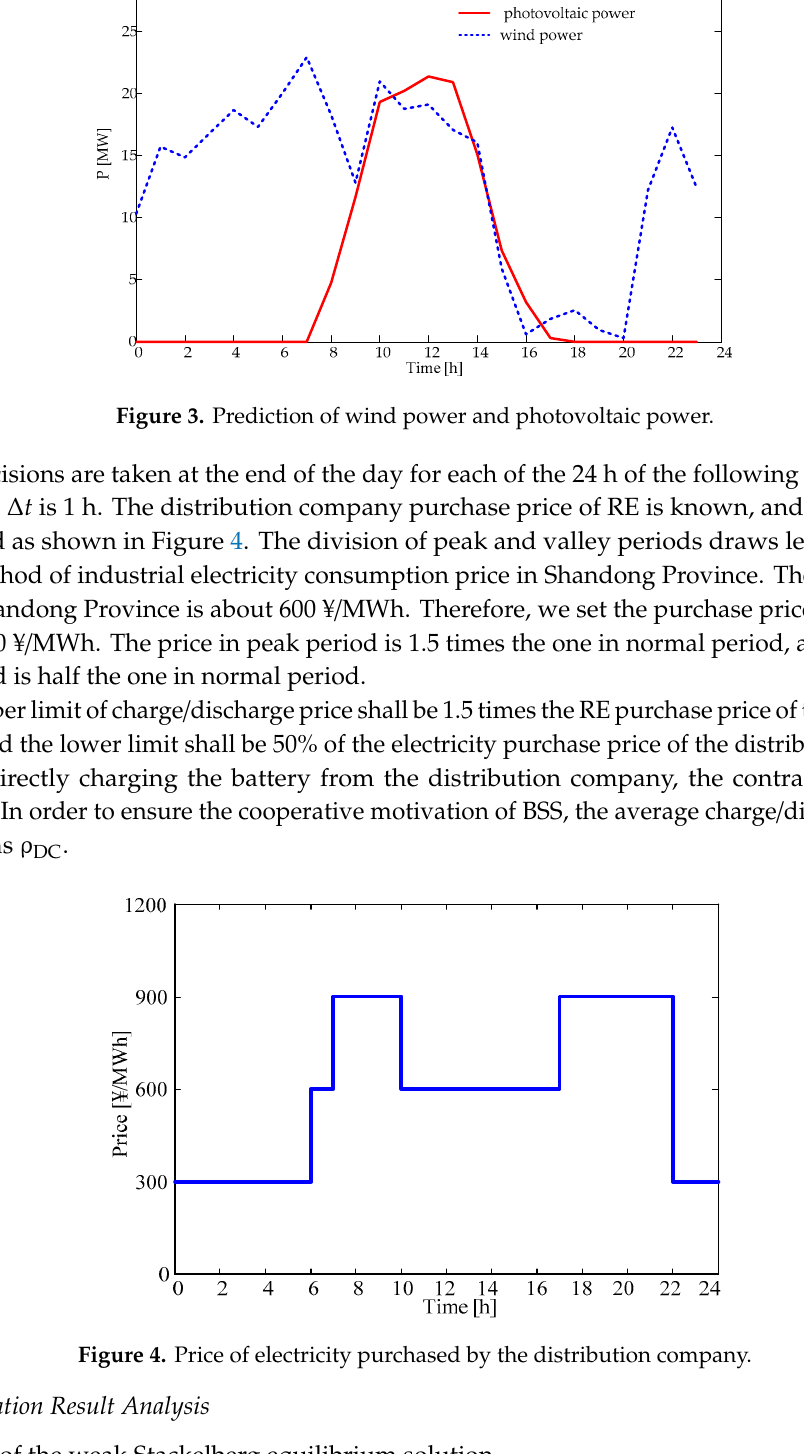
Figure 2. Prediction of battery-swapping demand.